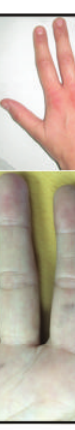
Figure 2: Hand and foot views. Note the curled toes and in particular the distinctive bilateral transverse creases involving the middle phalanx of the index finger (white